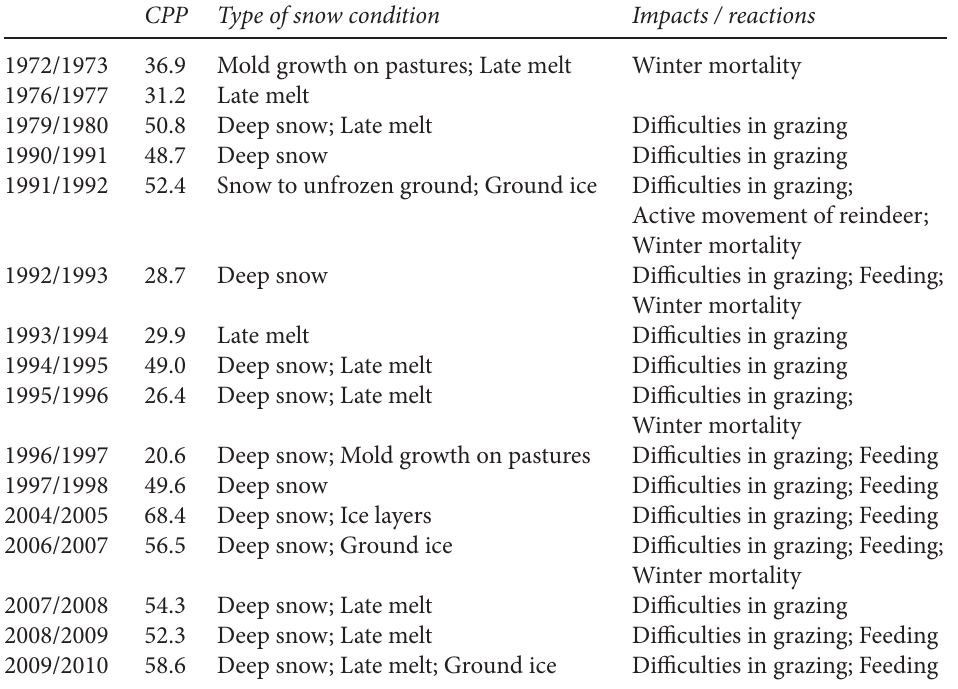
Table 2. Difficult snow conditions informed in the annual management reports of the Muonio reindeer herding district during 1972-2010. Calf production percentage (CPP), type of snow condition and re- ported impacts of snow conditions on reindeer populations (difficulties in grazing/active movement of reindeer/winter mortality) as well as responses of reindeer herding practices (feeding) are